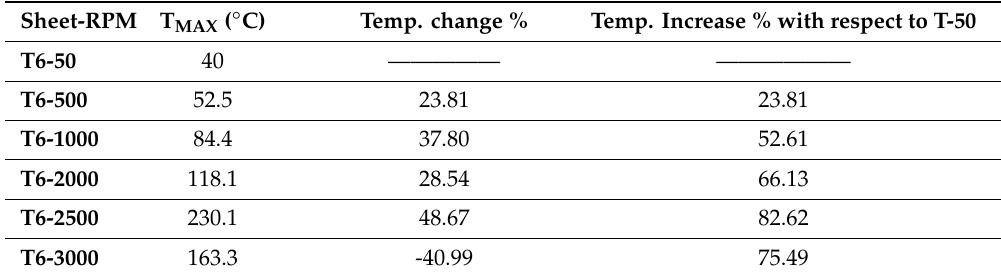
Table 4. Maximum temperature rises during ISF of T6 samples and percent increase in maximum temperature at varying tool rotation.